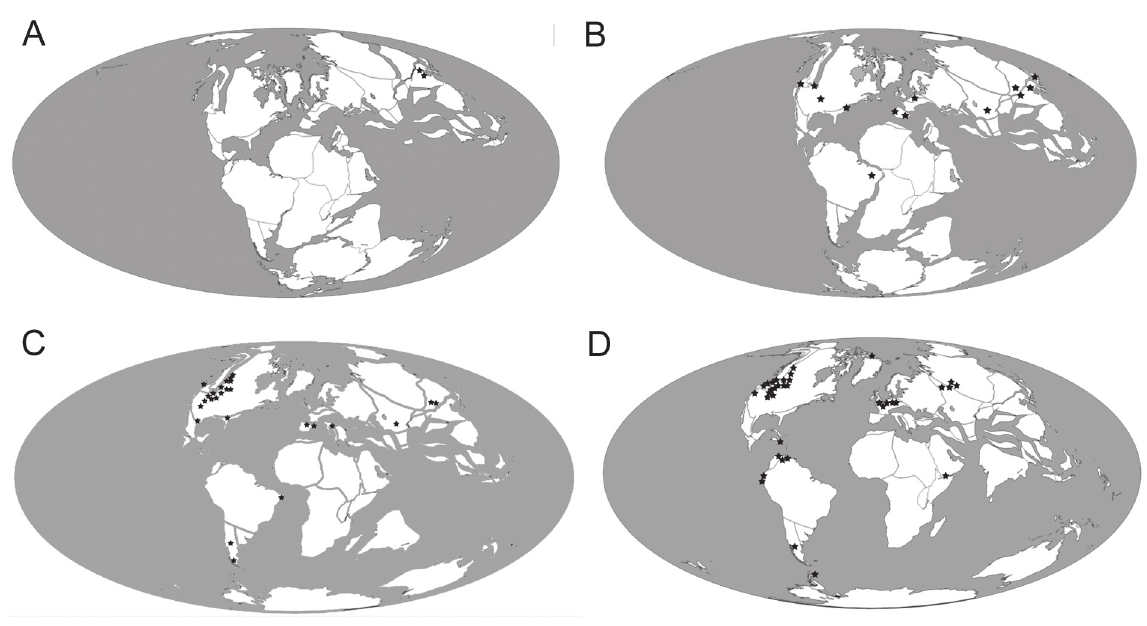
Figure 4 - Distribution map of angiosperms during Mesozoic and Cenozoic: A. First records at the Upper Jurassic. B. Early Cretaceous. C. Upper Cretaceous. D.